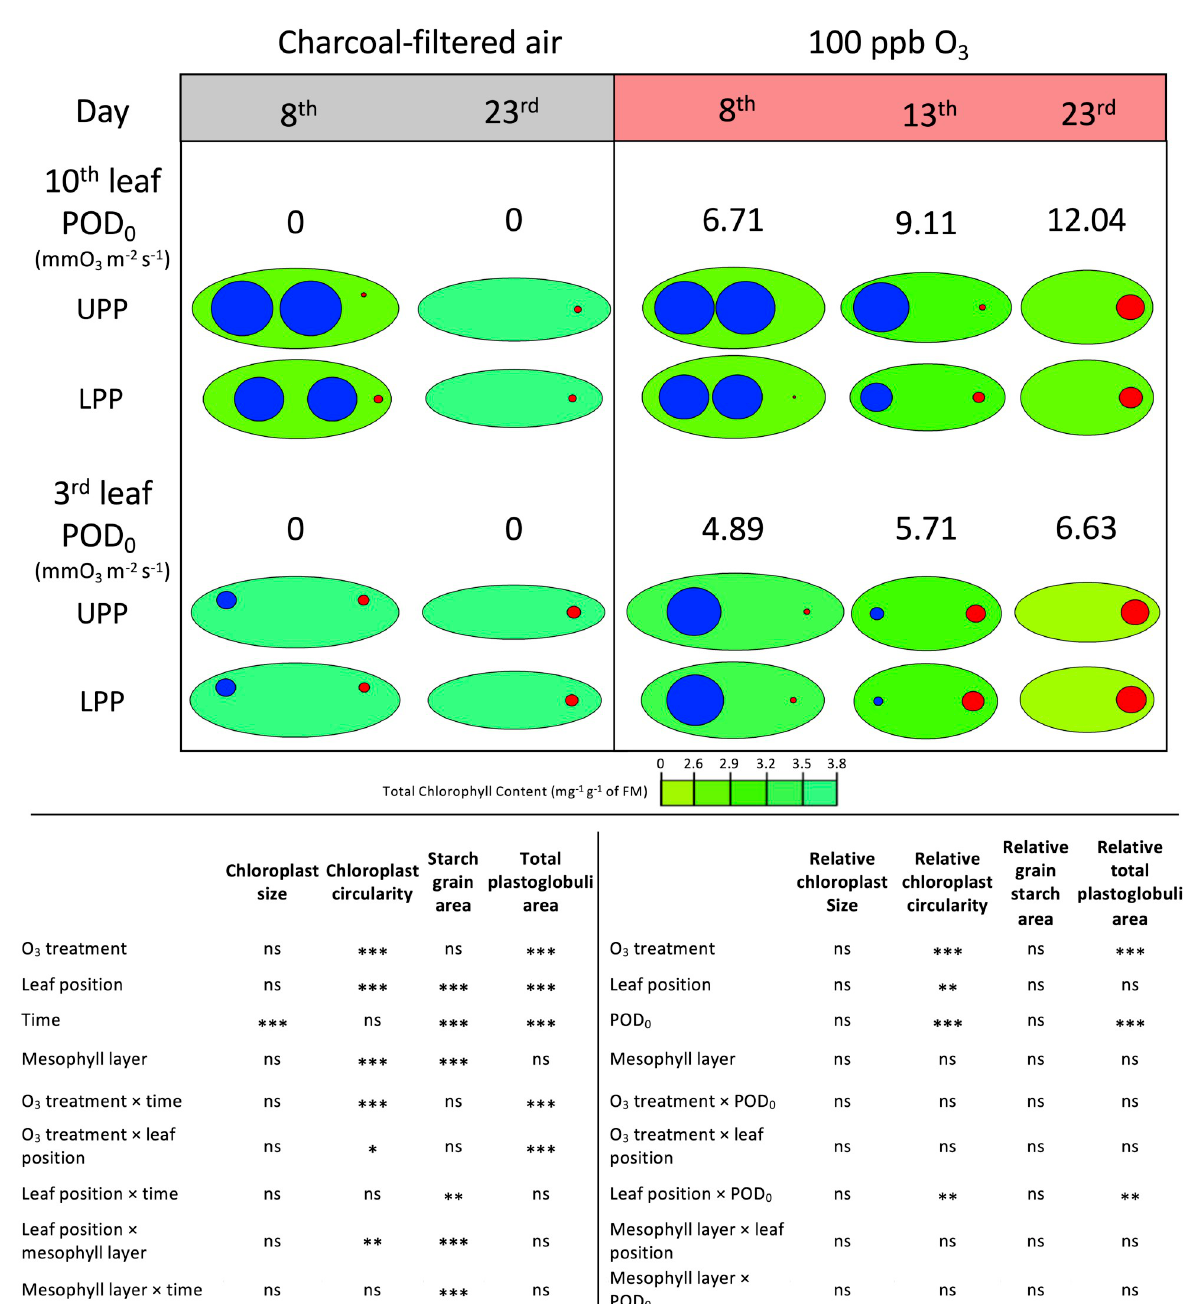
Fig 6. Visualization of chloroplast size and shape trait dynamics as a function of O 3 treatment, leaf position, assessment time or POD 0 , mesophyll layer, and interactions, as observed in the leaf mesophyll of hybrid poplar trees ( Populus tremula x alba ) on the 8 th , 13 th and 23 rd day of treatment. Model: lmer(variable ~ O 3 treatment � leaf position � time + (1 | cell/tree)); ��� P � 0.001, � P � 0.05, ns not significantly different). Data basis for the conceptual models of chloroplast trait changes: chloroplast long and short axis (green ellipse), cumulated starch grain and plastoglobuli percentage area (blue and red circles), total chlorophyll content (in mg g -1 FM; green color scale).